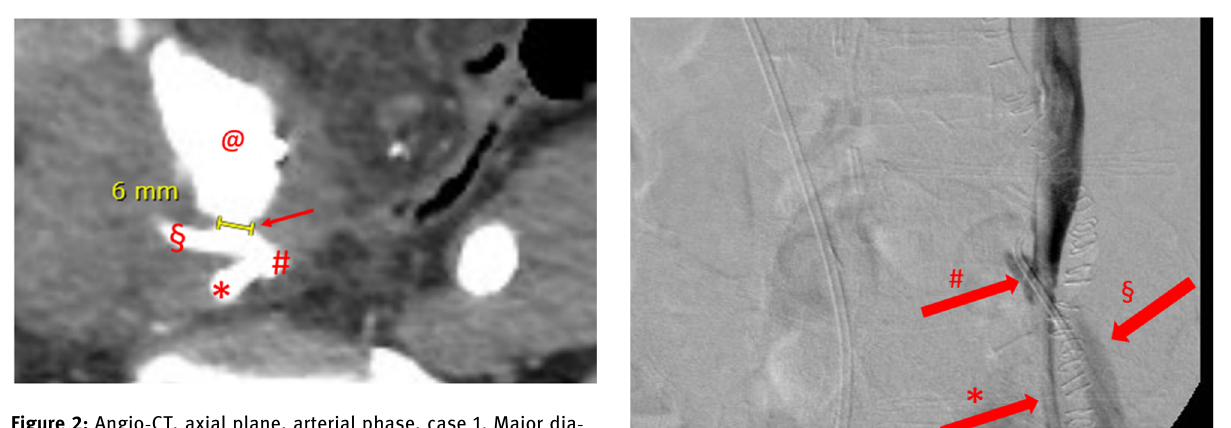
Figure 2: Angio - CT, axial plane, arterial phase, case 1. Major dia - meter of the UAF. Dart: UAF with concomitant iodinated contrast leakage; #: common right iliac artery bifurcation; *: hypogastric artery; §: external iliac artery; and @: pseudoaneurysm sac.